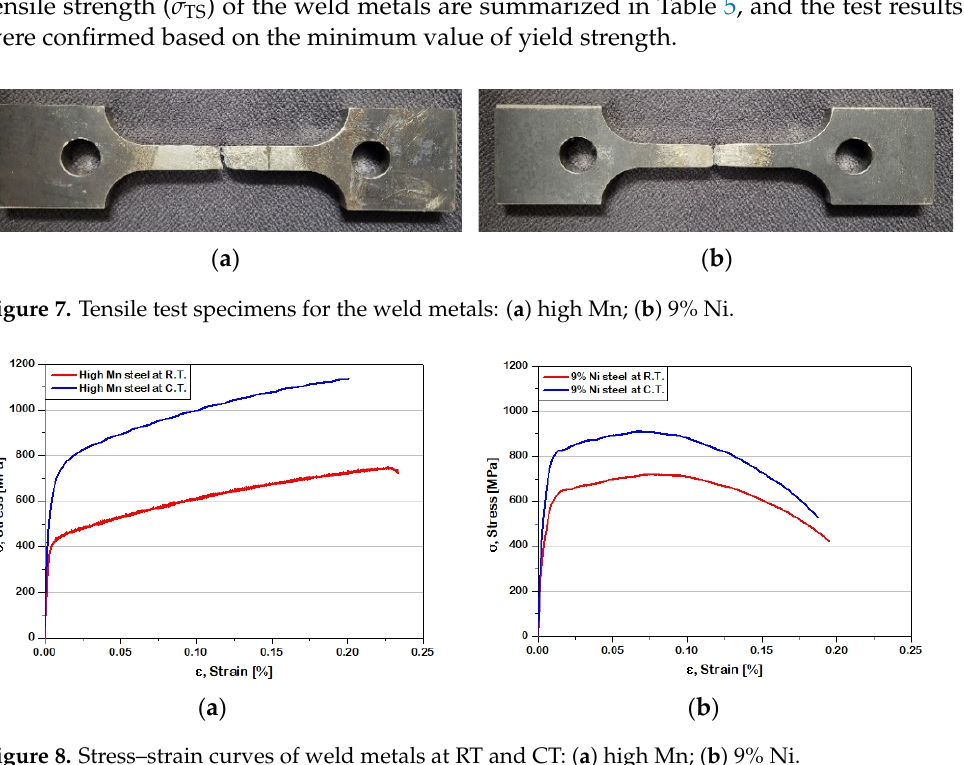
Figure 8. Stress–strain curves of weld metals at RT and CT: ( a ) high Mn; ( b ) 9% Ni. Table 5. Tensile test results of the weld metals.